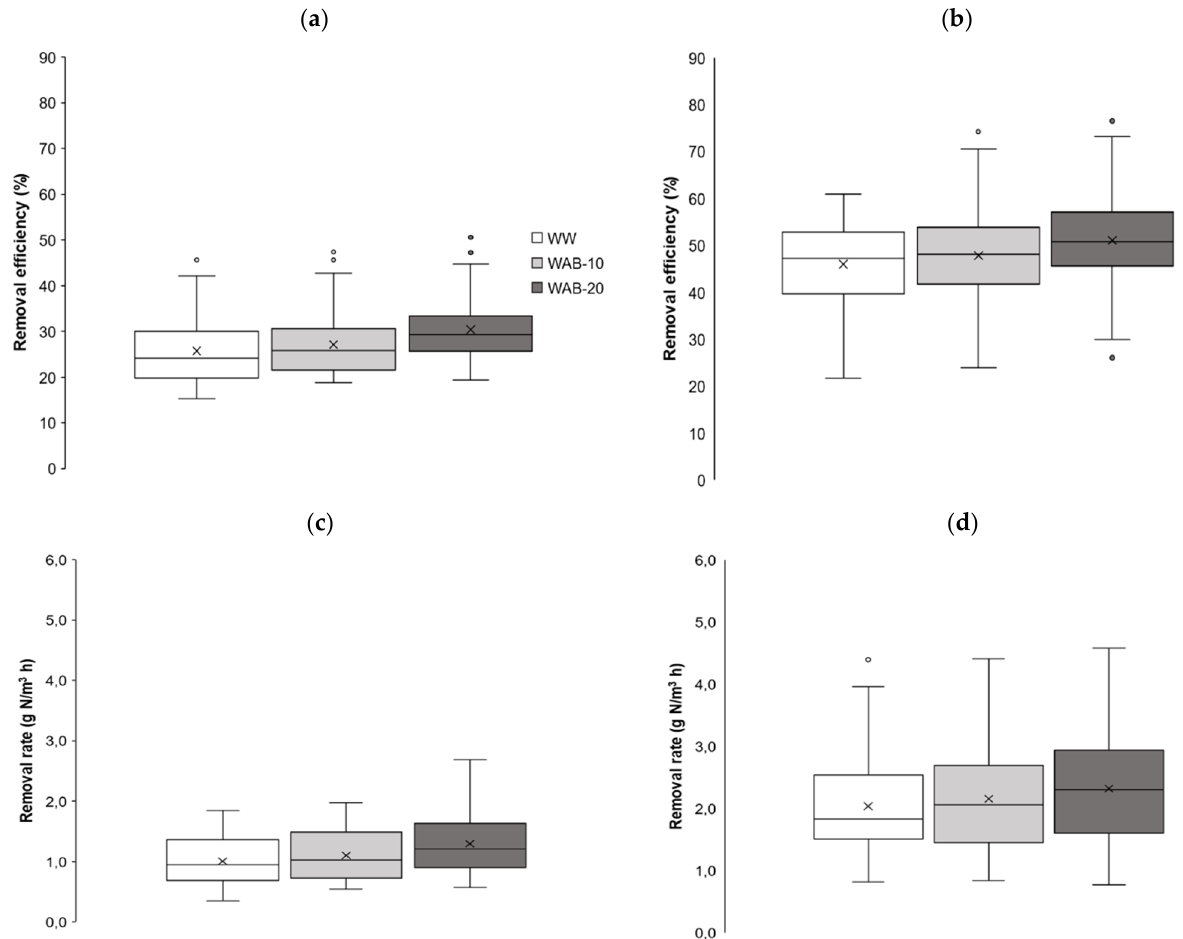
Figure 4. NO 3 -N removal efficiencies and rates between the WW, WAB-10, and WAB-20 bioreactors (the water temperature at the inlet was below 10 ◦ C in graphs ( a , c ), while it was above 10 ◦ C in graphs ( b , d ). The specific components in the graphs are the same as in Figure 2.